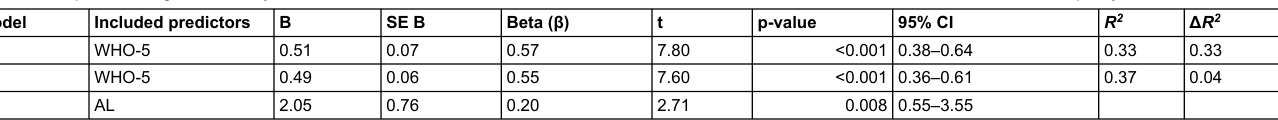
Table 4: Multiple linear regression analyses of the influence of allostatic load and relevant covariates on the mental health domain of health-related quality of life.